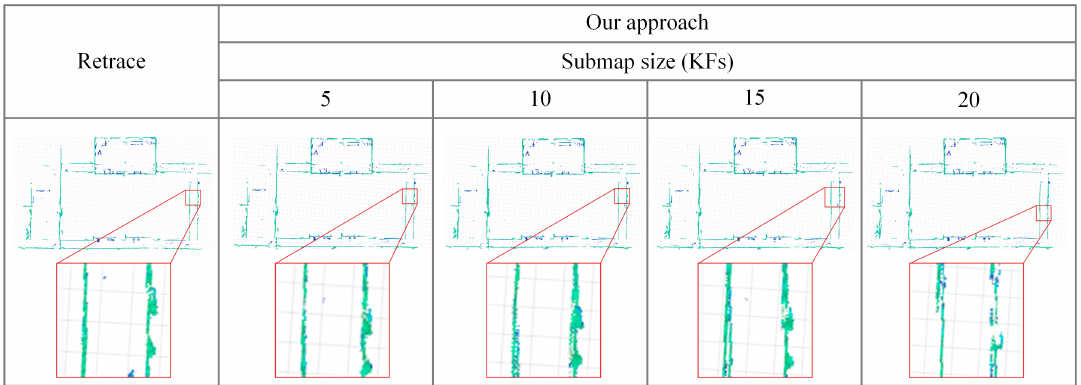
Figure 15. Top view of a map built by the retrace approach and top views of maps built by our approach with different submap sizes. The voxel size is 0.05